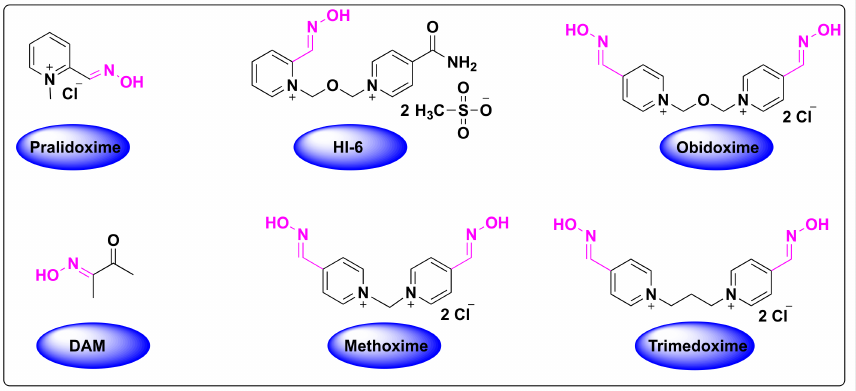
Figure 1. Chemical structures of oxime-based nerve antidotes.